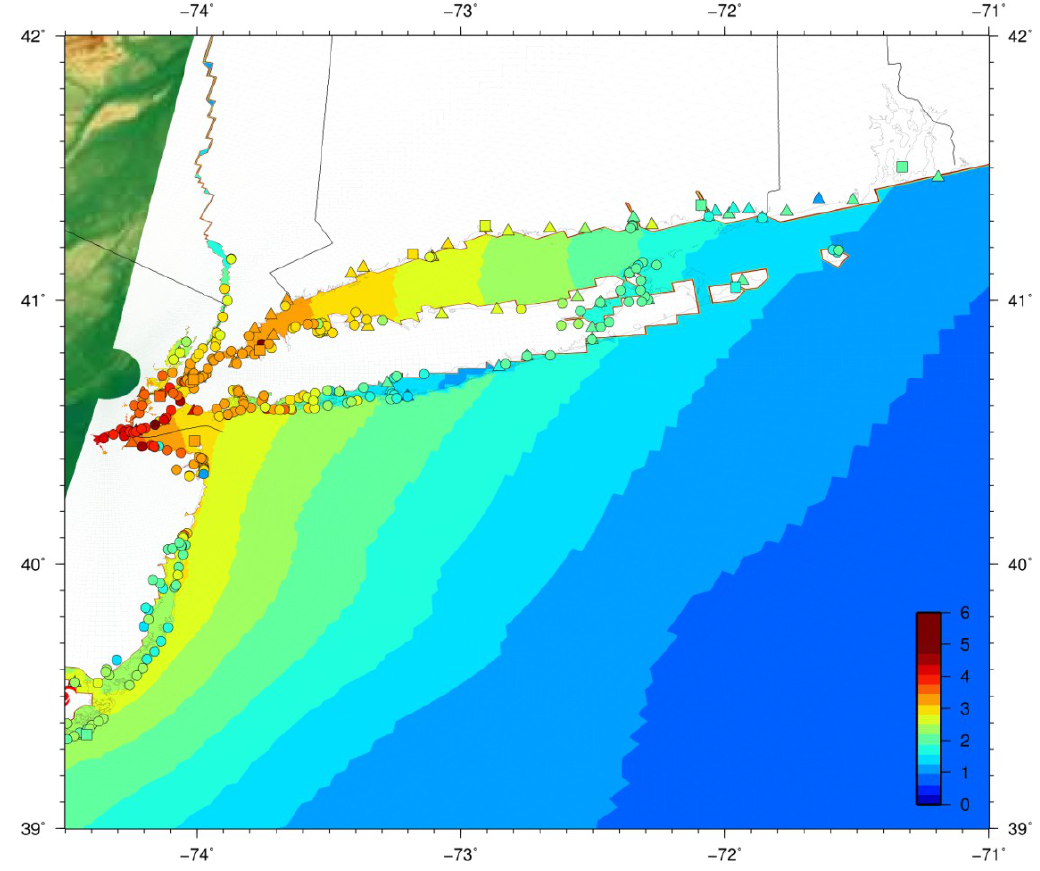
Figure 16. SLOSH model-simulated surge-plus-tides maximum envelope of water (relative to the NAVD88 vertical datum) for Hurricane Sandy. Observations at NOAA stations (squares), SSS (triangles) and HWM (circles) have been added with the same color range for comparison. Water levels are in